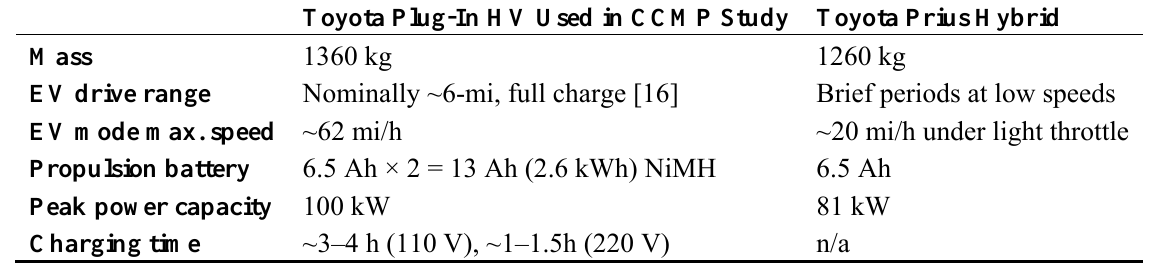
Table 1. Differences between the Toyota Plug-In HV and Toyota Prius (adapted from [14,15]). Toyota Plug-In HV Used in CCMP